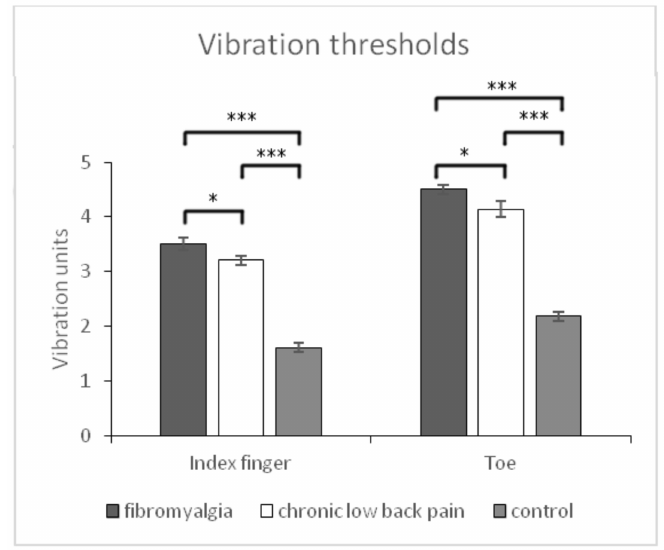
Figure 2. Means and typical errors for vibration thresholds at toe and index finger in the three groups of participants (fibromyalgia, chronic low back pain, and pain-free controls). * p < 0.05, *** p <